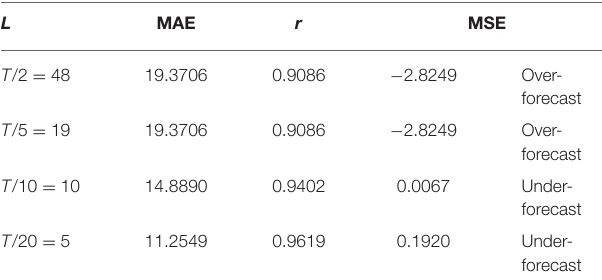
TABLE 2 | SSA-RF Prediction Performance Several Window Length ( L ).